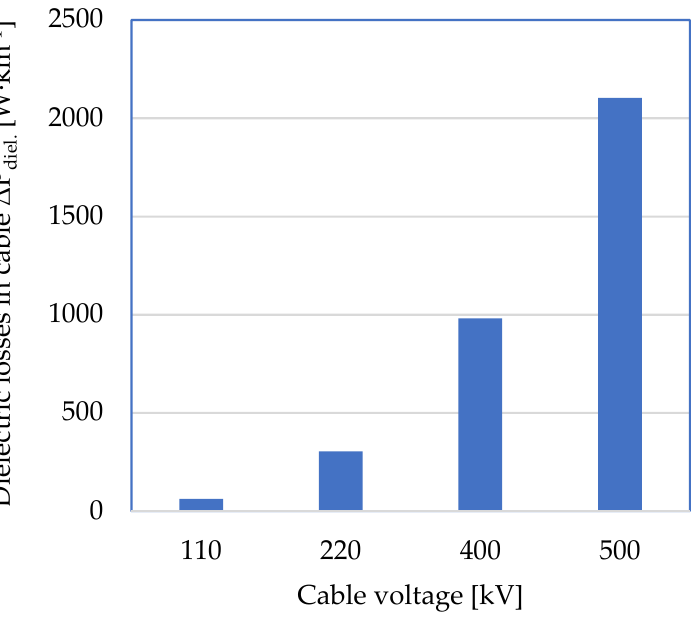
Figure 2. Dielectric losses in XLPE insulation for various high-voltage cables (110, 220, 400, and 500